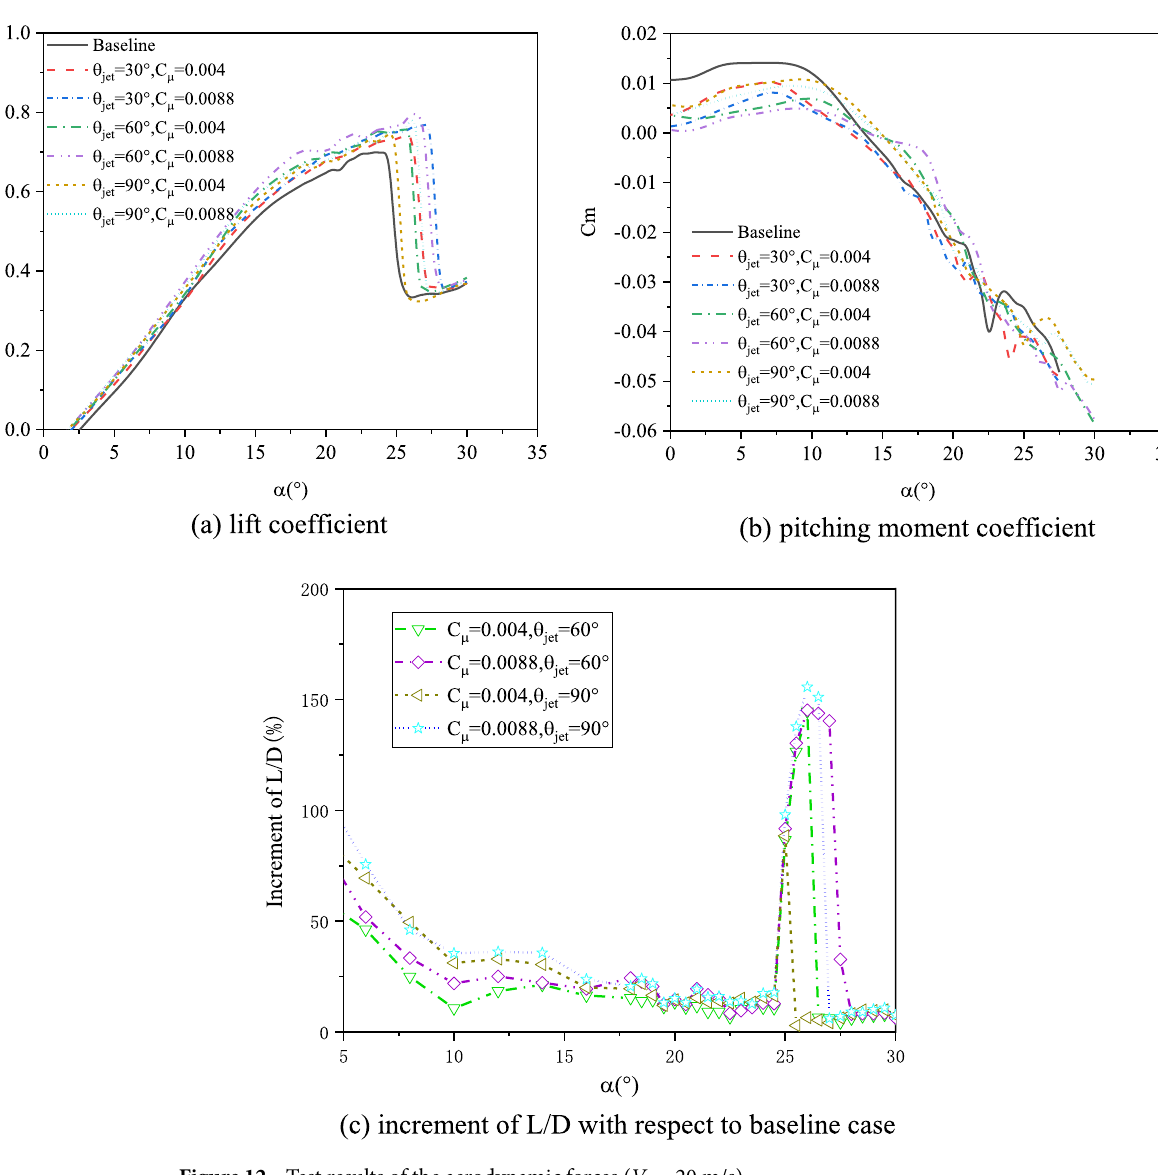
Figure 12. Test results of the aerodynamic forces ( V ∞ = 20